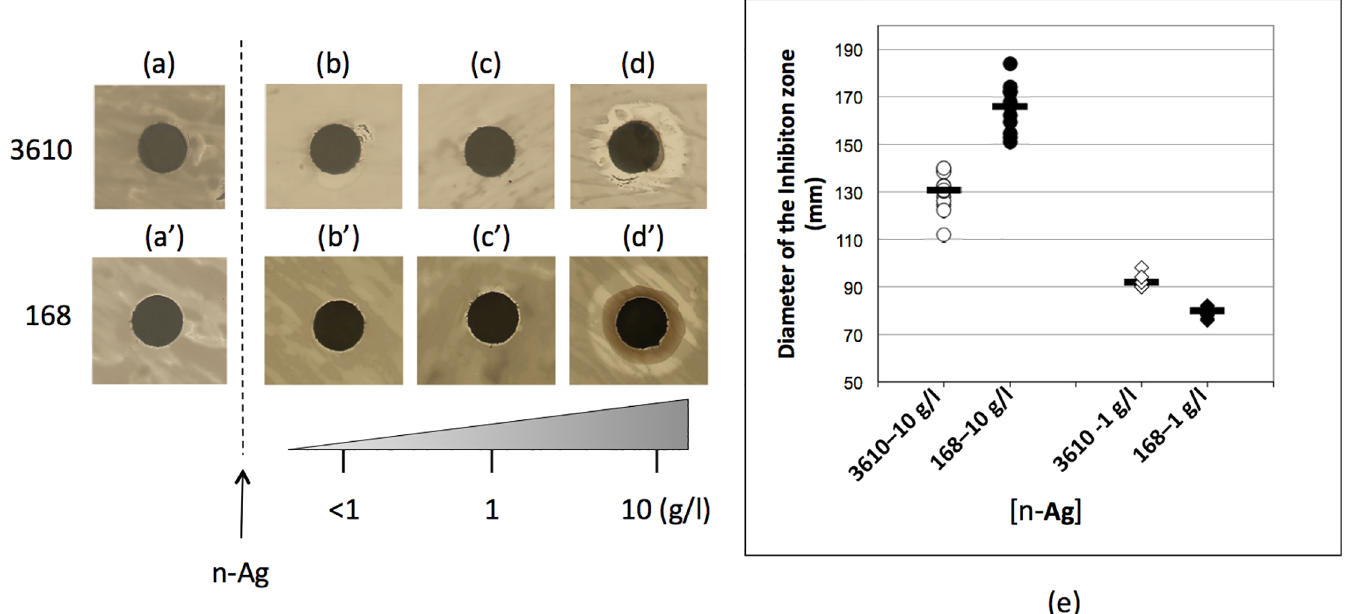
Fig 7. Inhibition zone after addition of n-Ag on Bacillussubtilis strains, 3610 and 168, in stationary phase. (a and a’), after 16h of bacterial growth on LB plate without n-Ag, (b-d’) 72 h after addition of n-Ag solutions, (b and b’), 10 μ l of [n-Ag] (cid:20) 1 mg/l, (c and c’), 10 μ l of [n-Ag] = 1 mg/l and (d and d’), 10 μ l of [n-Ag] = 10 mg/l, (e) graph plot of the measured diameter of the inhibition zone after addition of, circle, [n-Ag] = 10 mg/l, diamond, [n-Ag] = 1 mg/l, in white, strain 3610 and in black, strain 168. Black line, median.